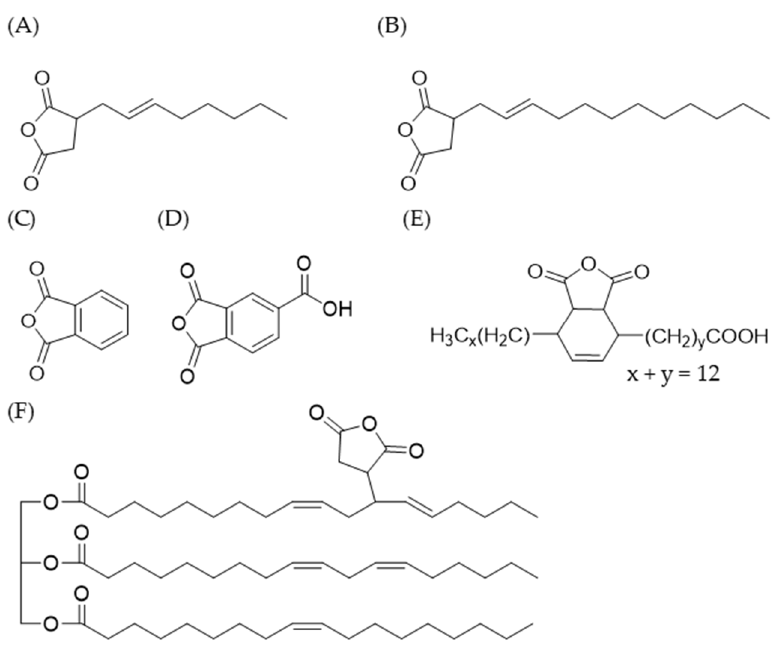
Figure 2. Chemical structure of ( A ) OSA, ( B ) DDSA, ( C ) phthalic anhydride, ( D ) 1,2,4-benzenetricarboxylic acid anhydride, ( E ) TENAX 2010, and ( F ) maleated soybean oil with one equivalent of maleic anhydride (many isomers possible).